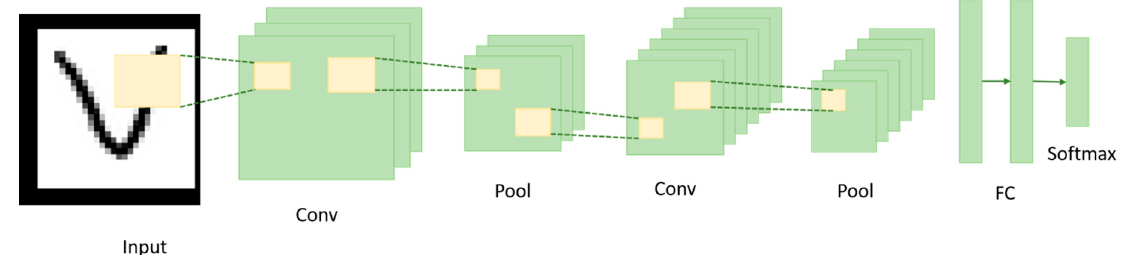
Figure 3. A typical convolutional neural network.